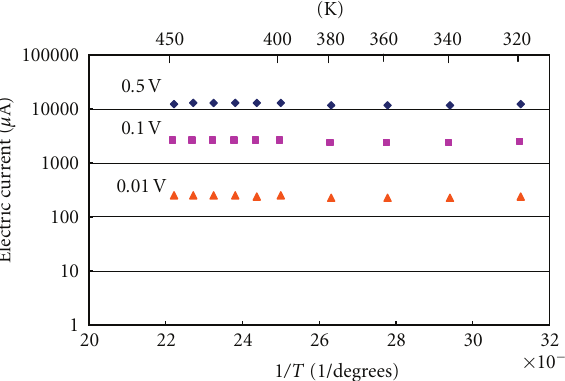
Figure 5: The arrhenius’s plots of electric currents of a sample measured in a vacuum chamber of 10 − 5 Torr under three applied voltages of 0.01, 0.1, and